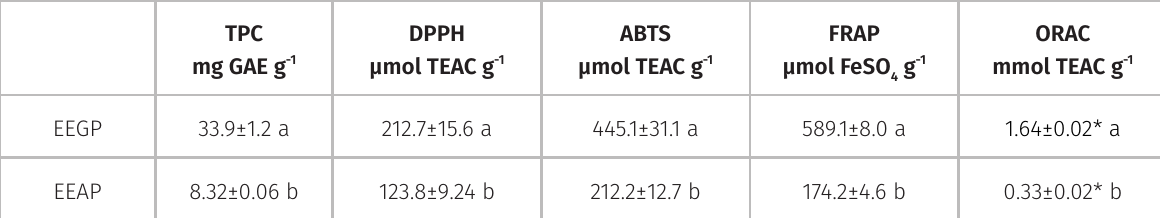
Table IV. Antioxidant activity and Total Phenolic Content of grape and apple pomaces extracts .